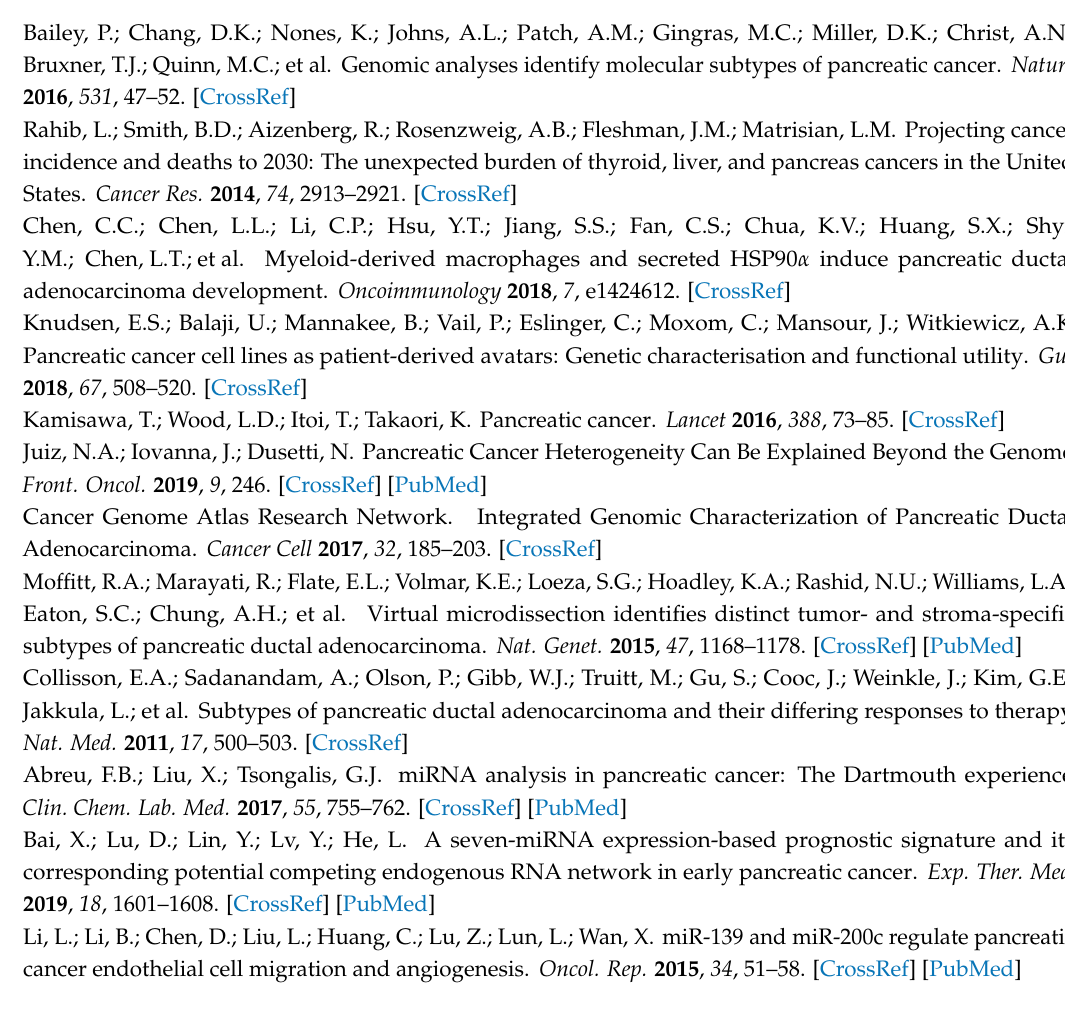
Table S2: Differential gene expression and Survival analyses of RBPs, Table S3: Differential gene expression and Survival analyses of PoRs, Table S4: Differential gene expression and Survival analyses of PsRs, Table S5: Gene expression of RBPs in PDAC cell lines, Table S6: Significantly enriched molecular functions and biological processes among the PoRs, Table S7: Dependency scores of PoRs in PDAC-derived cell lines, Table S8: Predicted PoR-miRNA